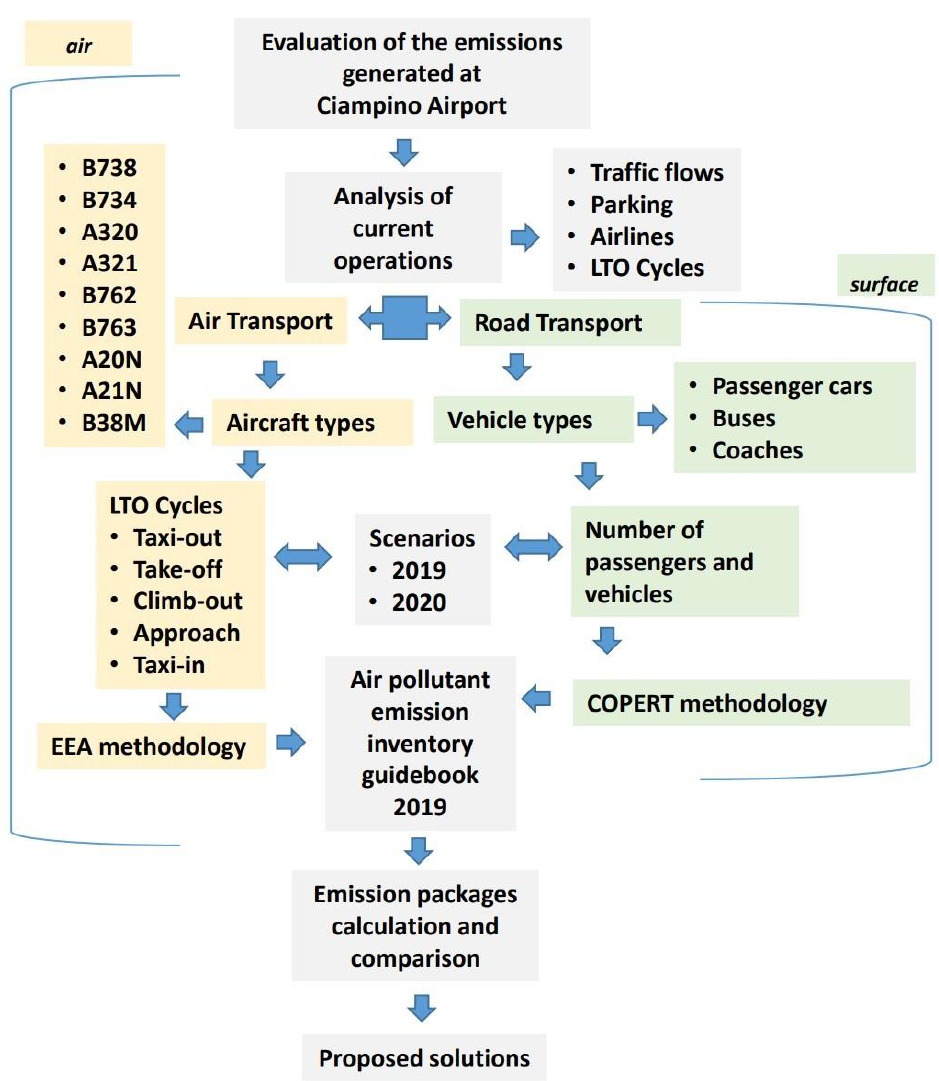
Figure 3. The methodology flowchart.